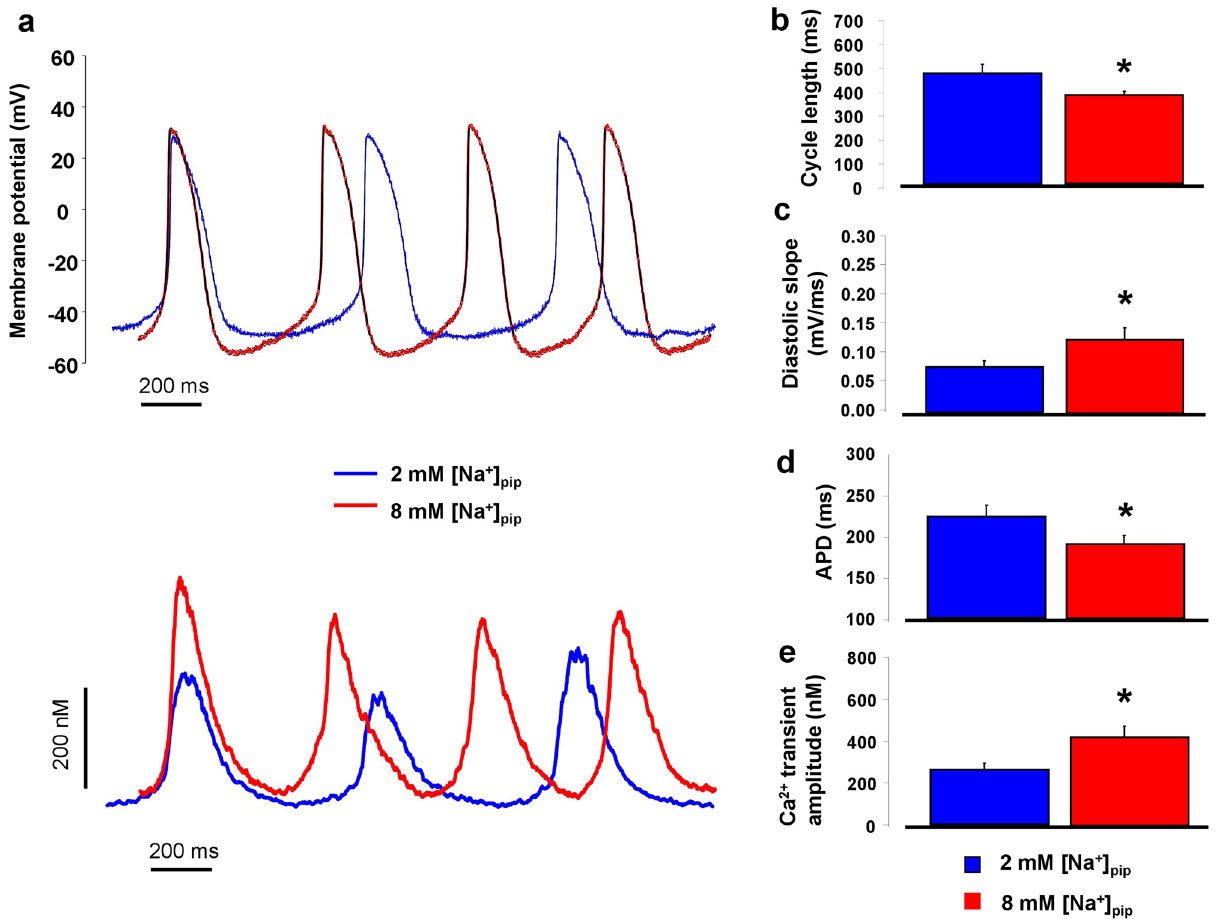
Figure 6. Comparison of spontaneous AP (panel a , upper traces) and CaT characteristics (panel a , lower traces) between 2 mM (blue traces) and 8 mM (red traces) [Na] pip groups, measured by whole-cell patch clamp technique. Bar graphs indicate that the cycle length of spontaneous APs (panel b ) was shorter, the diastolic slope (panel c ) was steeper, the APD (panel d ) was shorter and CaT amplitude (panel e ) was larger in the 8 mM [Na] pip group (red columns) compared to 2 mM [Na] pip group (blue columns). Data shown as mean ± SEM, n = 8–8, independent t-test, *means p < 0.05.